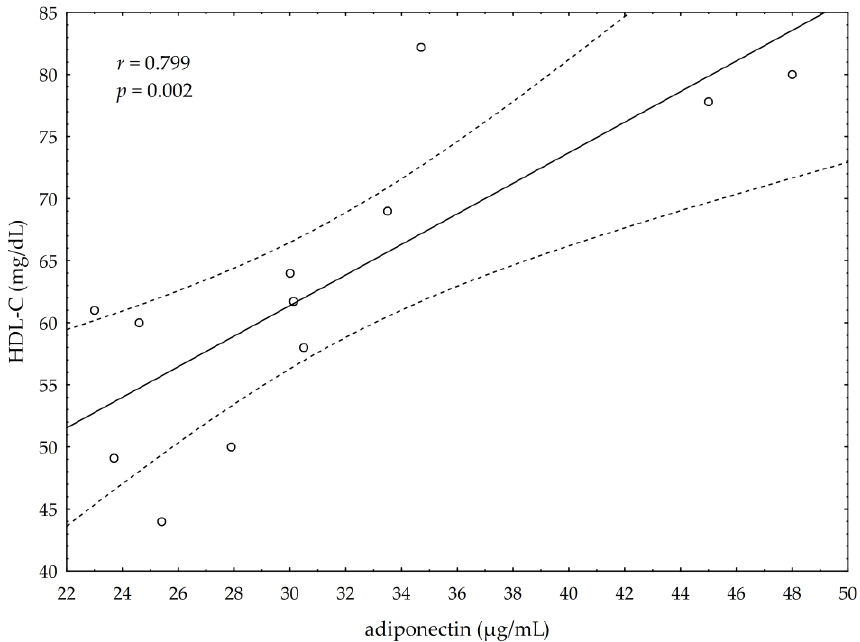
Figure 4. Correlation of high density lipoprotein cholesterol (HDL-C) and serum adiponectin lev- els.